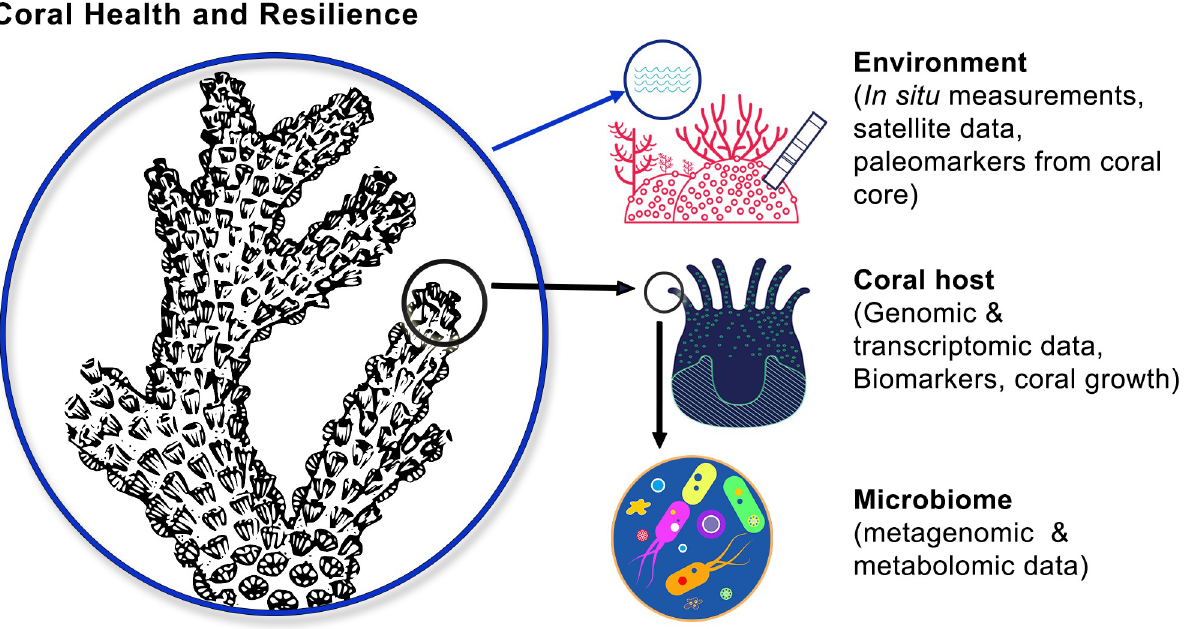
Fig 2. Schematic representation of the frame and major goals of Tara Pacific, which is investigating jointly the coral, microbiome, and environment.